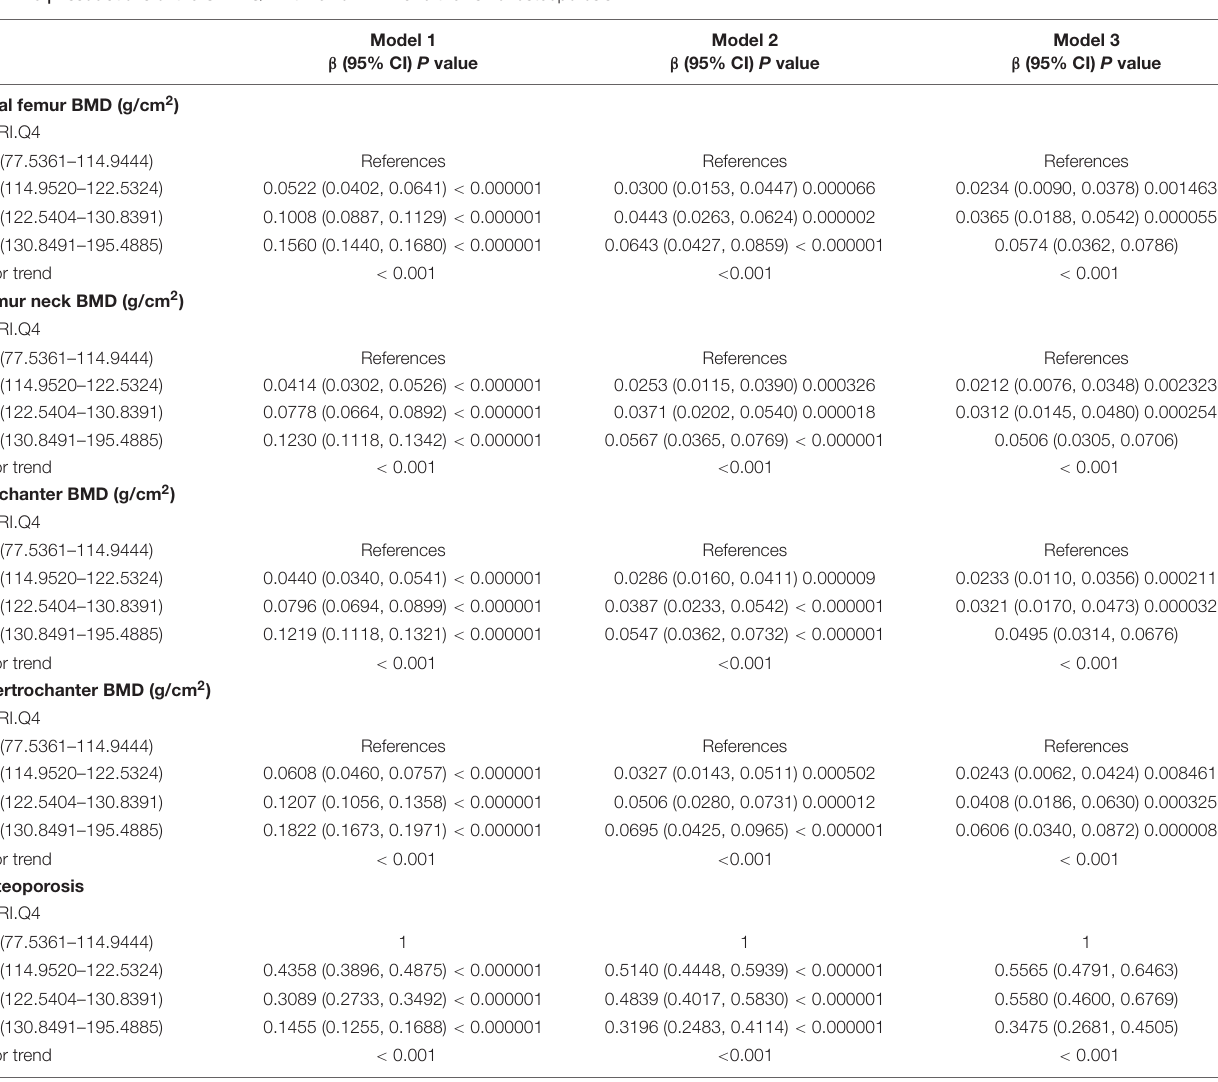
TABLE 3 | Associations of the GNRI.Q4 with femur BMD and the risk of